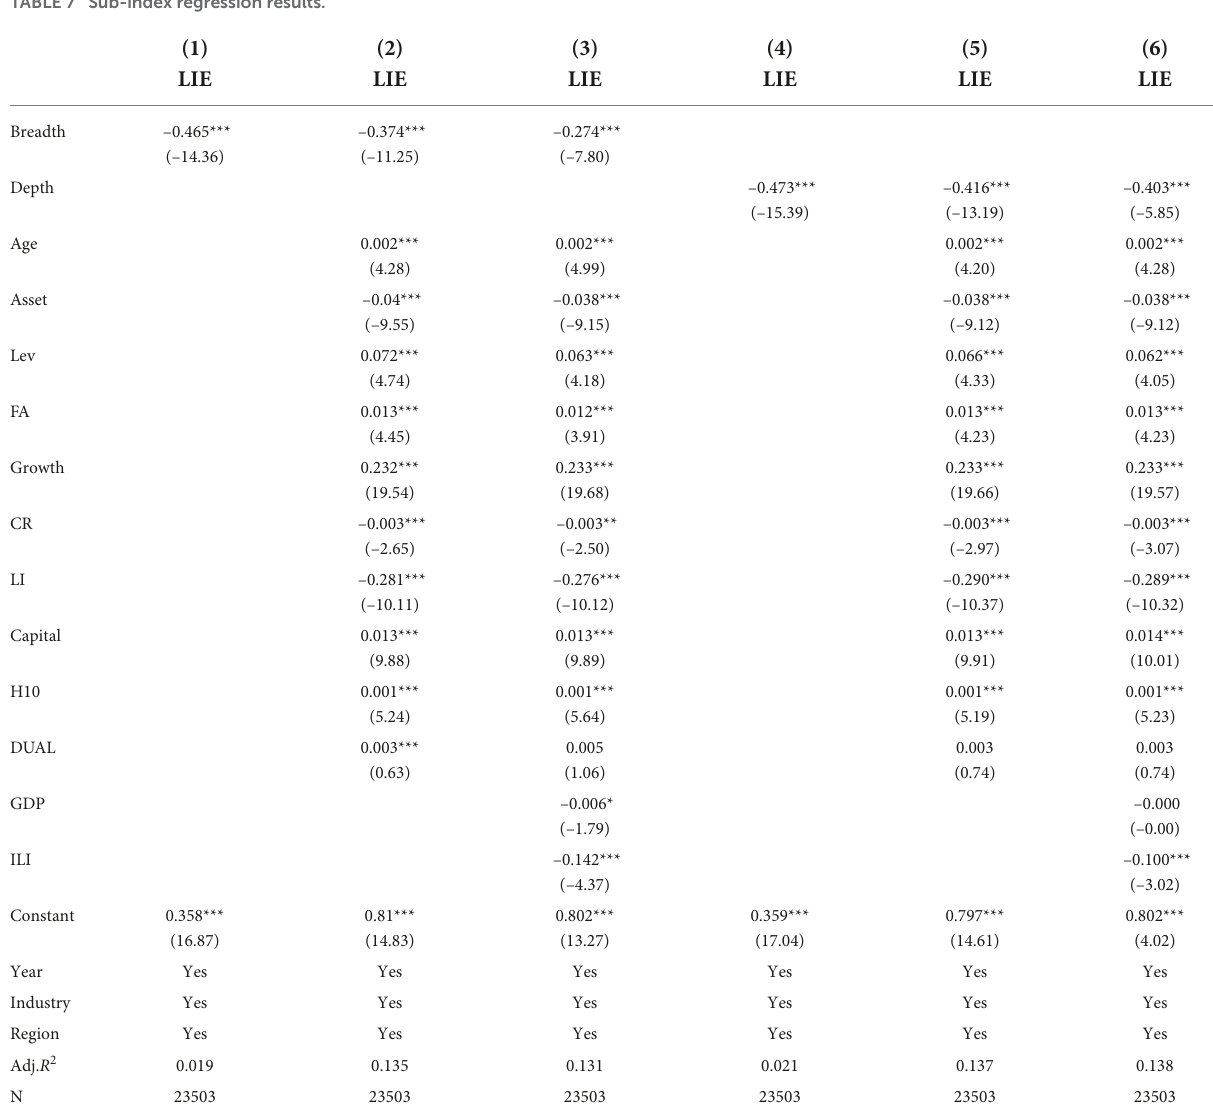
TABLE 7 Sub-index regression